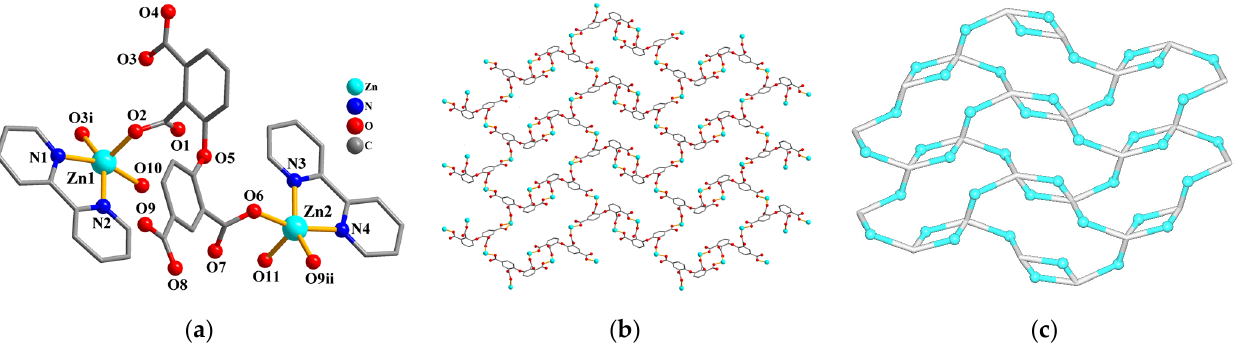
Figure 3. Structural fragments of 3 . ( a ) Coordination environment around Zn(II) atoms; H atoms are omitted for clarity. Symmetry codes: i = − x , − y + 1, − z ; ii = − x + 1/2, y − 1/2, − z + 1/2. ( b ) 2D metal-organic layer; view along the a axis. ( c ) Topological representation of 2D layer with an hcb topology; view along the a axis; Zn(II) centers (cyan balls), centroids of µ 4 -dpa 4 − nodes (gray).